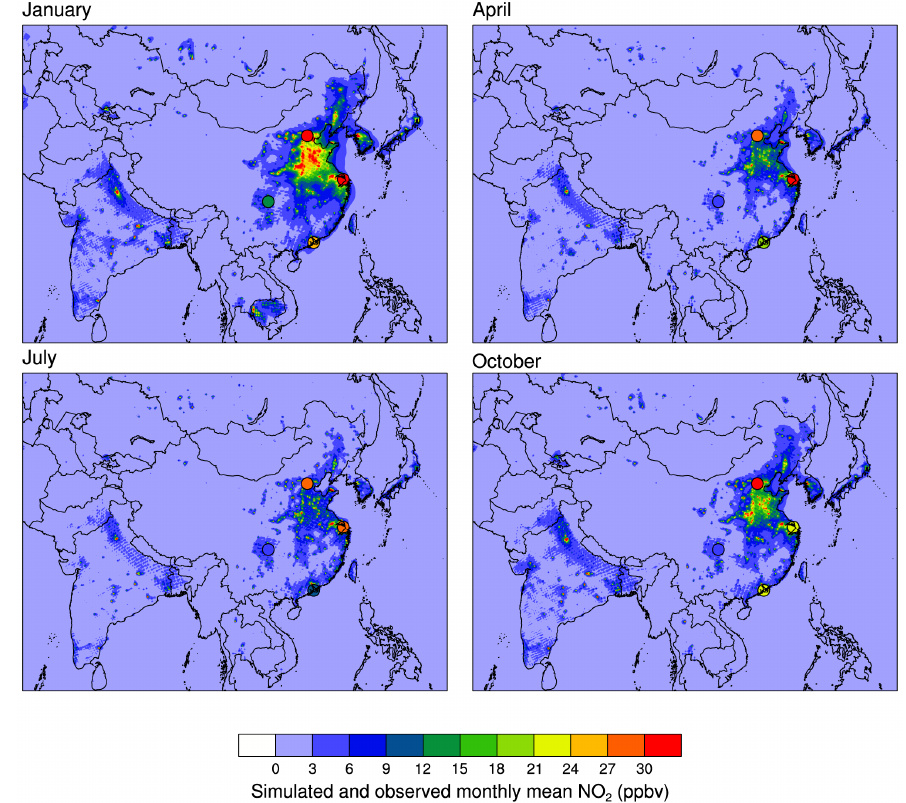
Figure 10. Simulated and observed monthly average surface NO 2 in 2007 using WRF-Chem–REAS. The filled circles indicate the observed monthly average